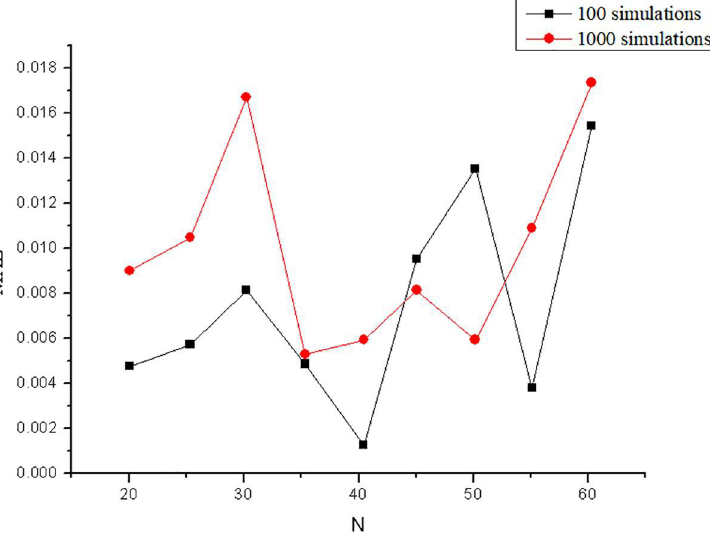
Fig 5. Average absolute error of different simulation times under importance